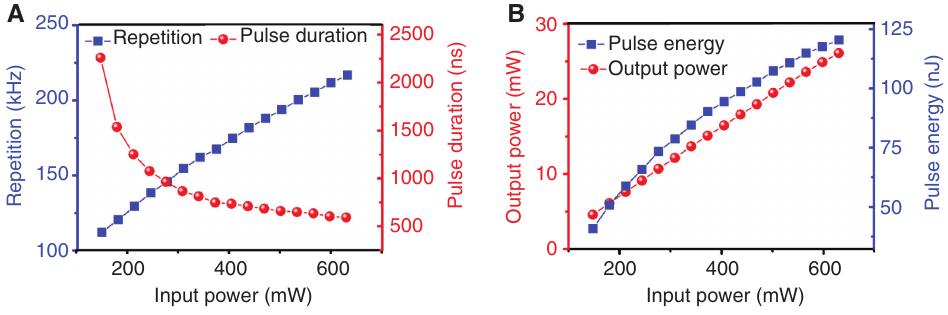
Figure 6: Characteristics of proposed QSFL variation under different power. (A) Pulse duration and repetition rate as functions of input power. (B) Average output power and pulse energy as functions of input power.